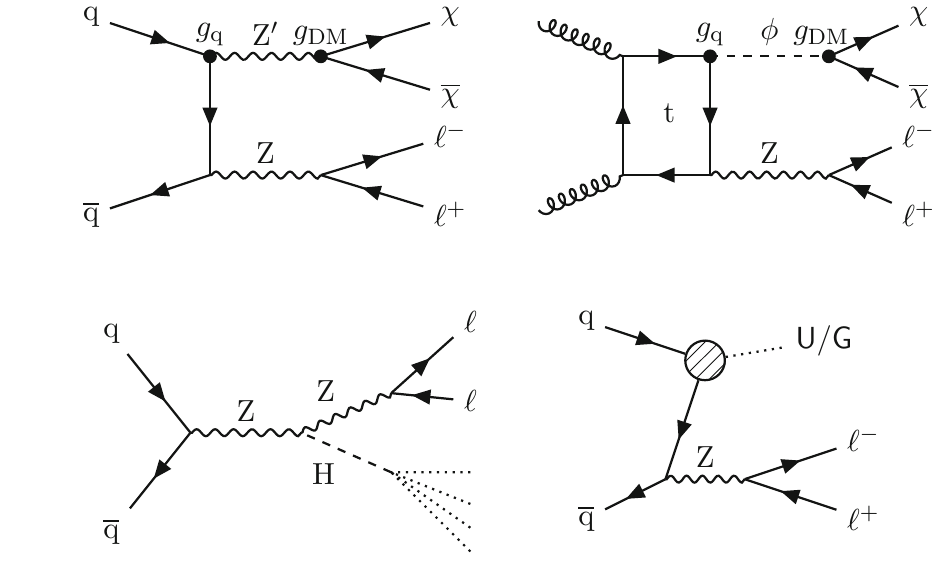
illustrative of the processes beyond the SM considered in this paper: (upper left) DM production in a simplified model with a spin-1 mediator Z (cid:4) ; (upper right) DM production in a simplified model with a spin-0 mediator φ ; (lower left) production of a Higgs boson in association with Z boson with subsequent decay of the Higgs boson into invisible particles; (lower right) unparticle or graviton production. The diagrams were drawn using